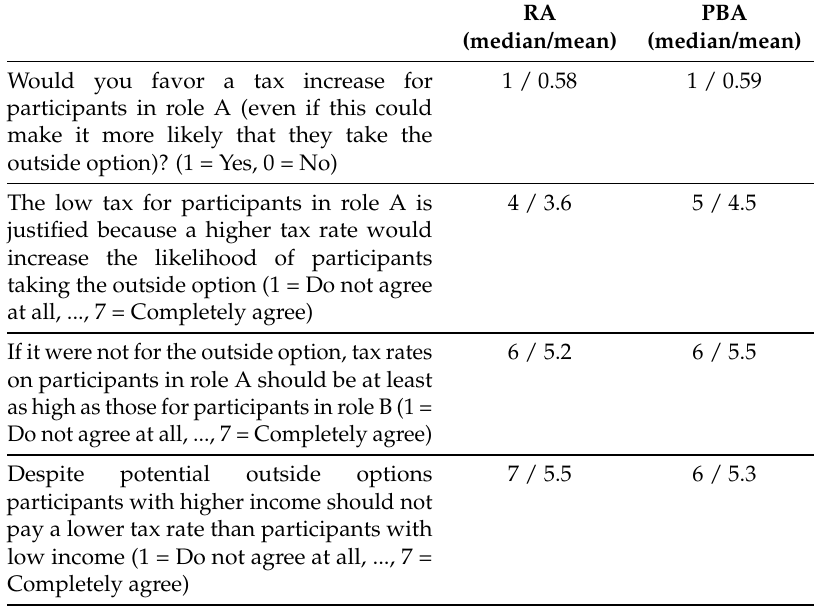
Table A6. Nonparametric tests for allocation effects on compliance choices.